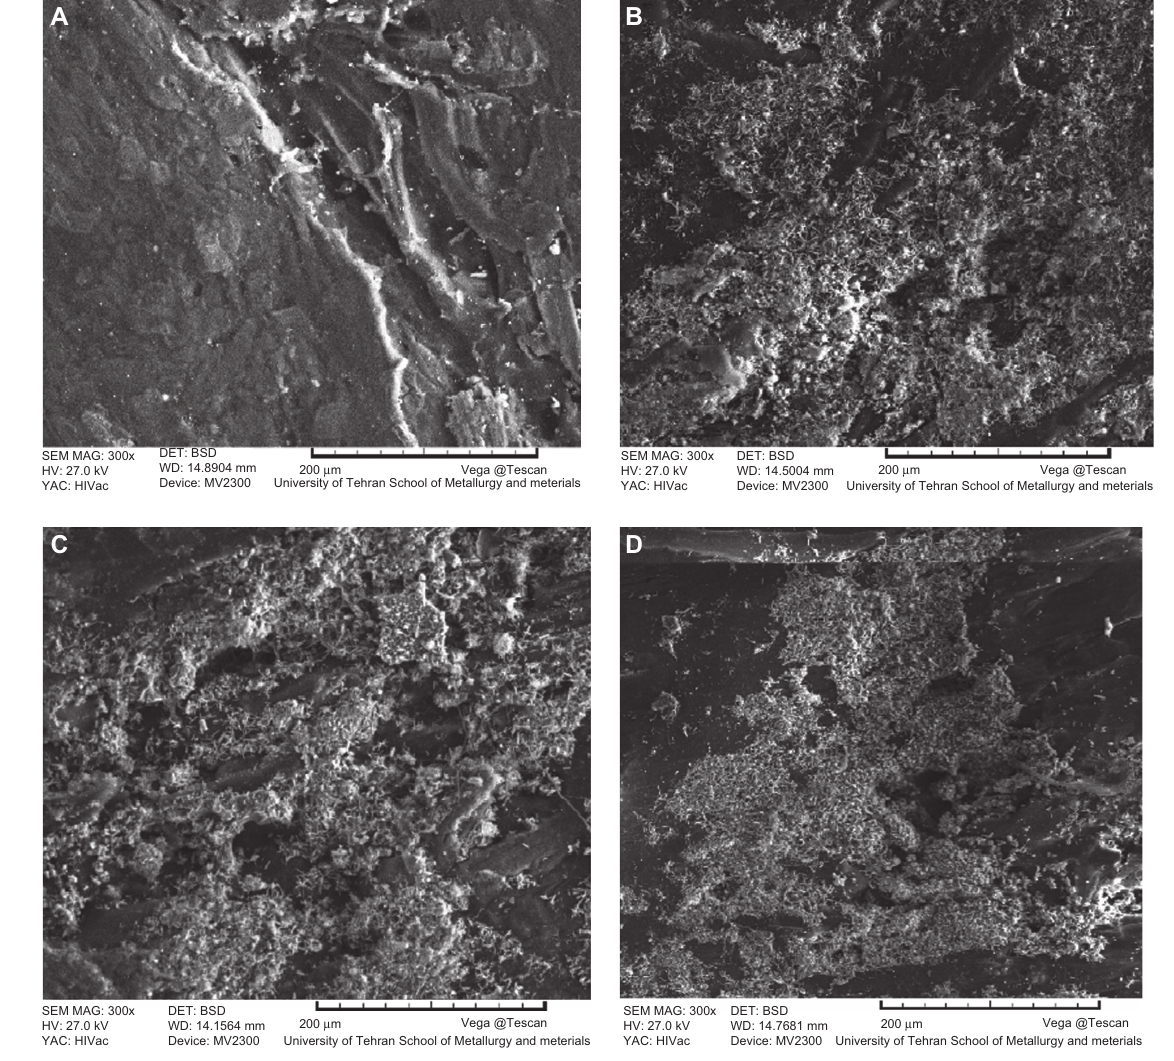
Figure 4 SEM micrograph of the fracture surfaces in the composites against fungal decay at different exposure times. (A) Control sample, (B) 8 weeks, (C) 12 weeks, (D) 16